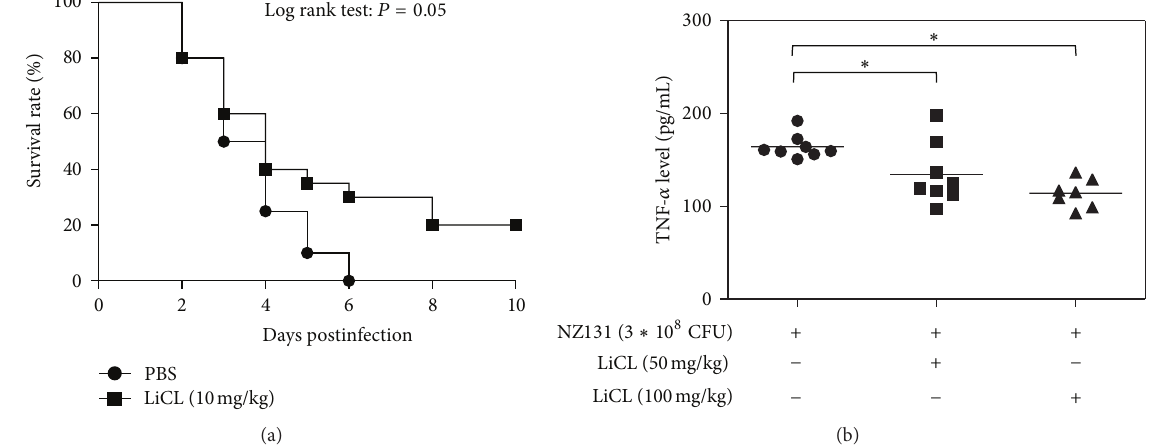
Figure 4: GSK-3 inhibitor, LiCl, can reduce the mortality induced by NZ131 infection in mice and suppress the TNF- 𝛼 level in sera after NZ131 infection. (a) LiCl (10mg/kg) was intraperitoneally administered immediately and at 12, 24, and 36 h after the inoculation of NZ131 (3 × 10 8 CFU) into the air pouch created on the back of BALB/c mice ( 𝑛 = 20 per group). The Kaplan-Meier method was used to determine the difference of survival rate after NZ131 infection. P value was analyzed by log rank test ( 𝑃 = 0.05 ). (b) LiCl was given intraperitoneally once immediatelyafterinoculationofNZ131intoairpouchandmiceweresacrificed24 hafterinfectionwhenserumwascollectedformeasurement of TNF- 𝛼 ( 𝑛 = 8 in NZ131 alone group, 𝑛 = 8 in LiCl 50mg/kg group, and 𝑛 = 7 in 100mg/kg group).